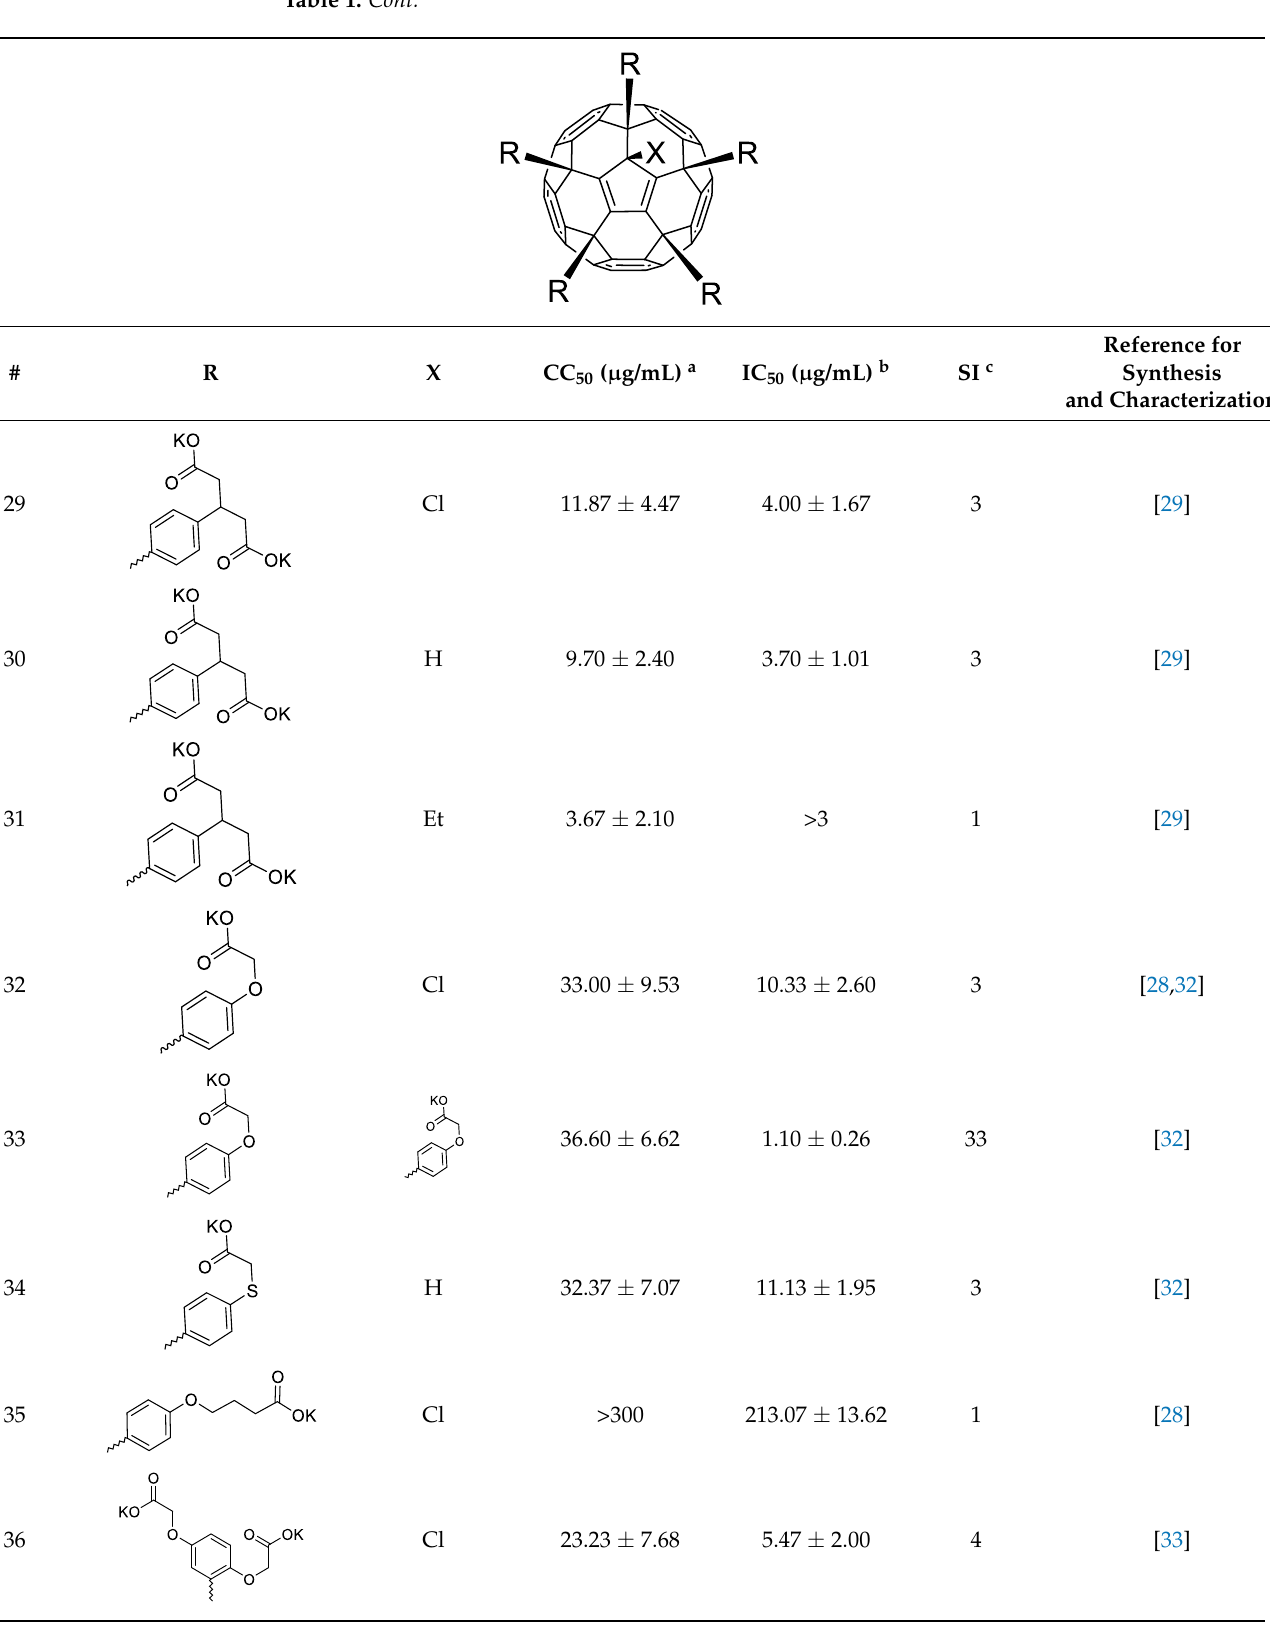
Table 1. Antiviral activity of the water- soluble fullerene derivatives against Influenza А/Puerto Table 1. Cont. Rico/8/34 (H1N1) virus in MDCK